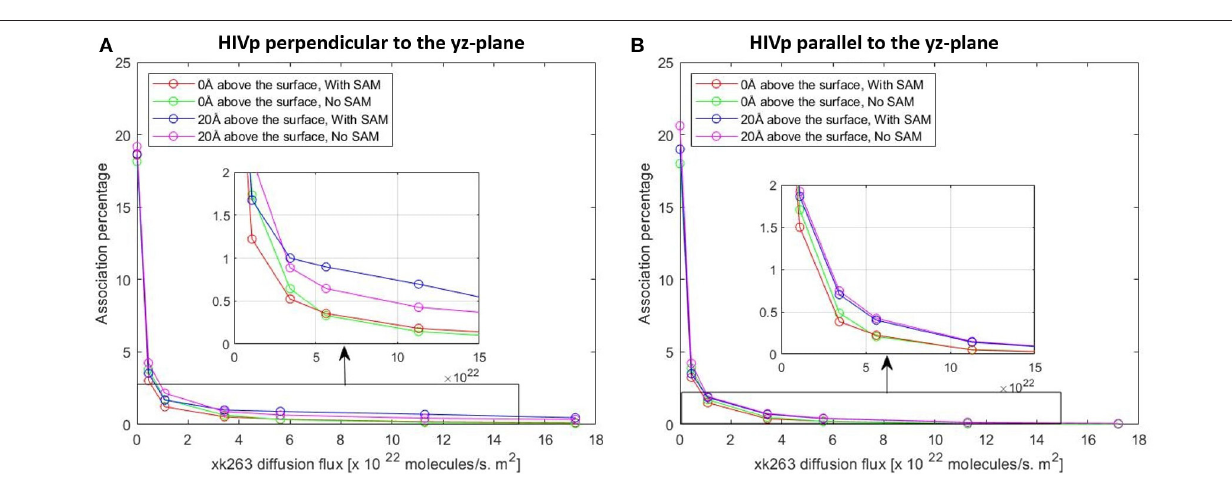
FIGURE 8 | Plot of association percentage vs. xk263 diffusion flux under two different HIVP’s orientation (A,B) . Association percentage is defined as the fraction of successful binding from the total number of trajectories in the